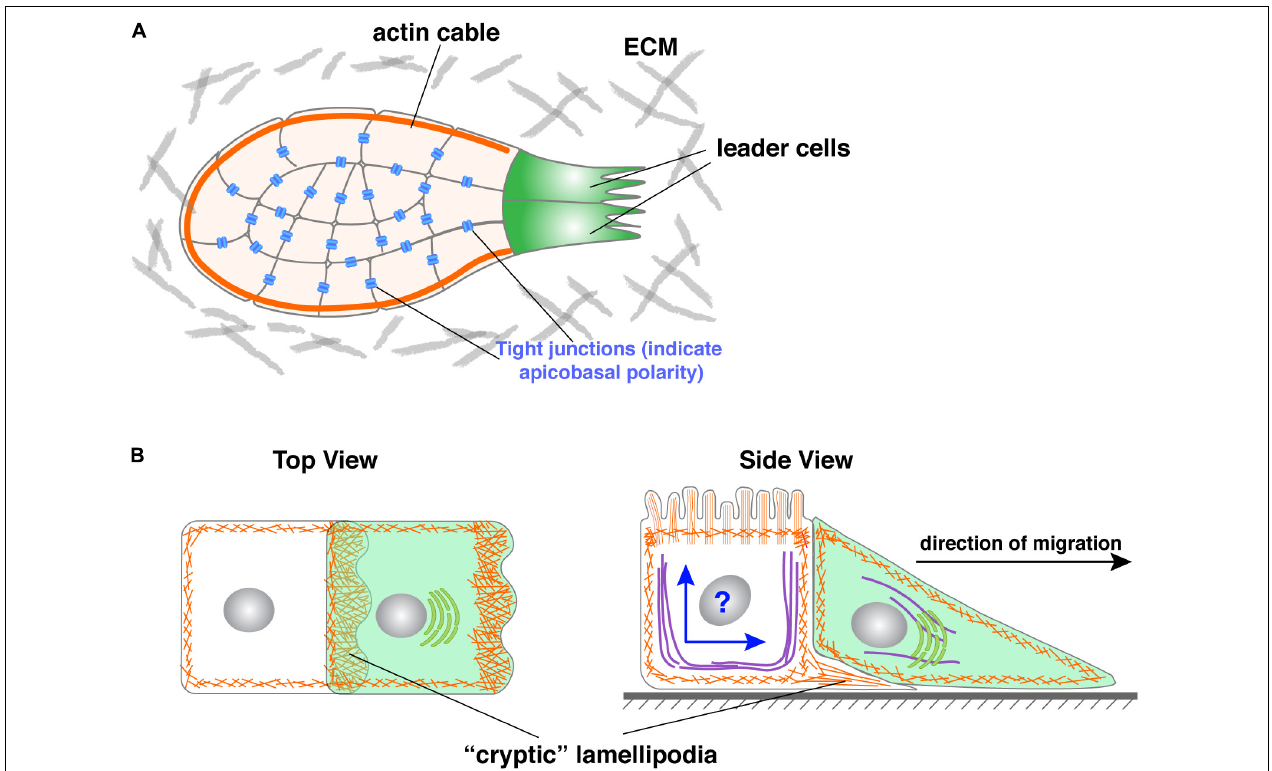
FIGURE 5 | Roles of follower cells during collective migration. (A) Periphery follower cells in some models, including neural crest, form actin “cable” whose contraction could propel the forward movement of the collective. Note that actin cable could be a misnomer as it might not represent what the actin-polymer looks like in 3D. (B) Follower cells in some models have been shown to form cryptic lamellipodia, which can generate force and promote collective migration. However, as shown in the side view, an essential question is how the follower solves the potential conflict of having two polarities, namely apicobasal and front-rear polarities simultaneously in the same cell when they are mutually exclusive in all other models